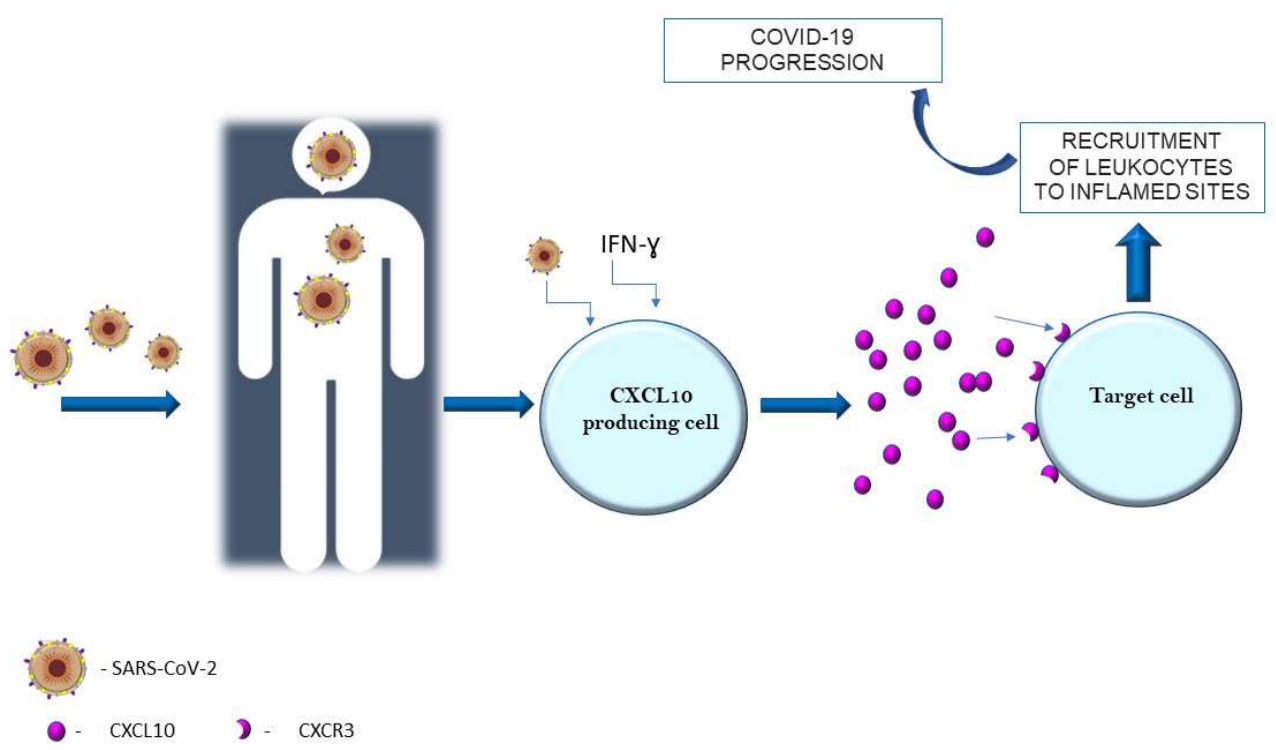
Figure 1. CXCL10 in SARS-CoV-2 infection.